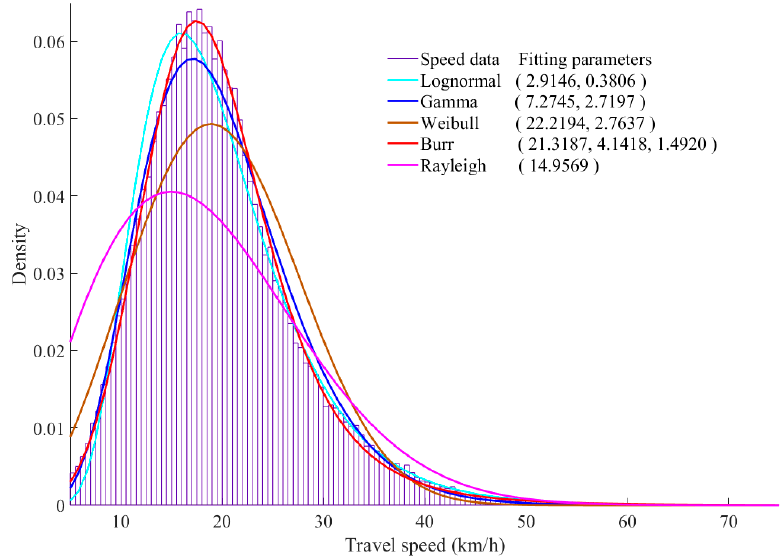
Figure 5. Fitted distributions for the observed travel speed data on October 13.